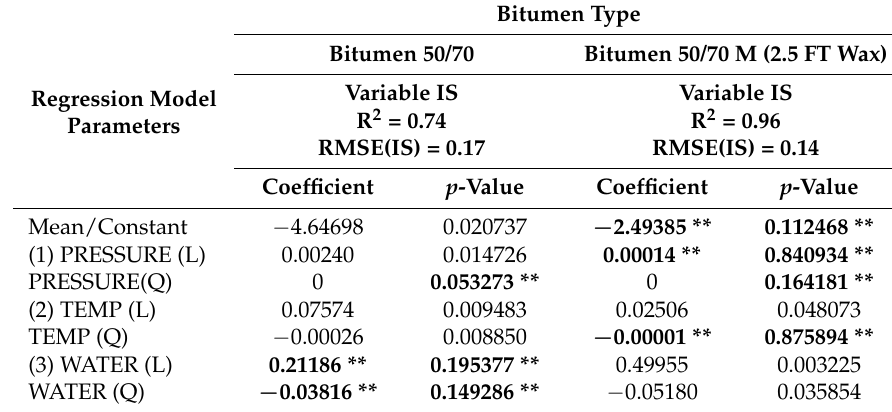
Table 7. Fitting parameters of the objective function of IS for bitumen 50/70 and bitumen 50/70 M (2.5% FT